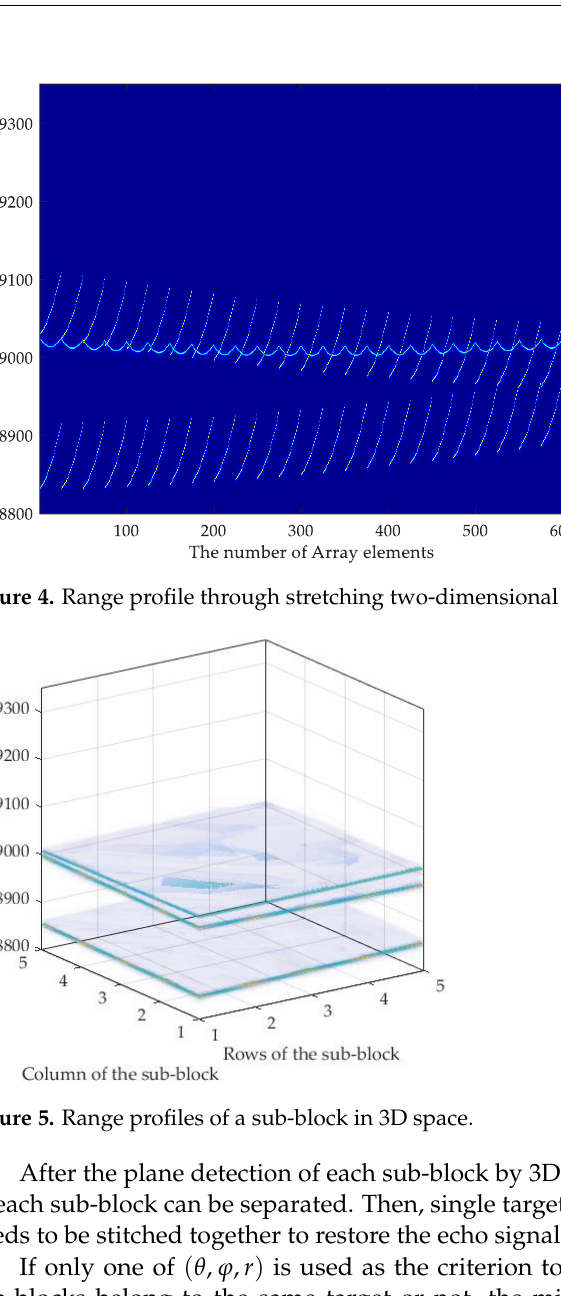
Figure 5. range profiles of a sub-block in 3D space.